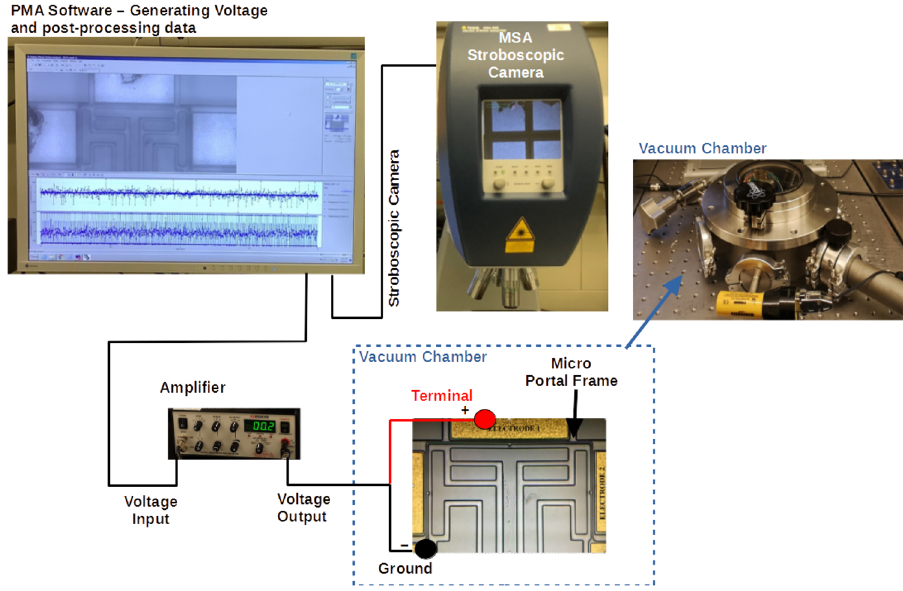
Figure 3. Experimental setup for the data acquisition of the micro portal frame.